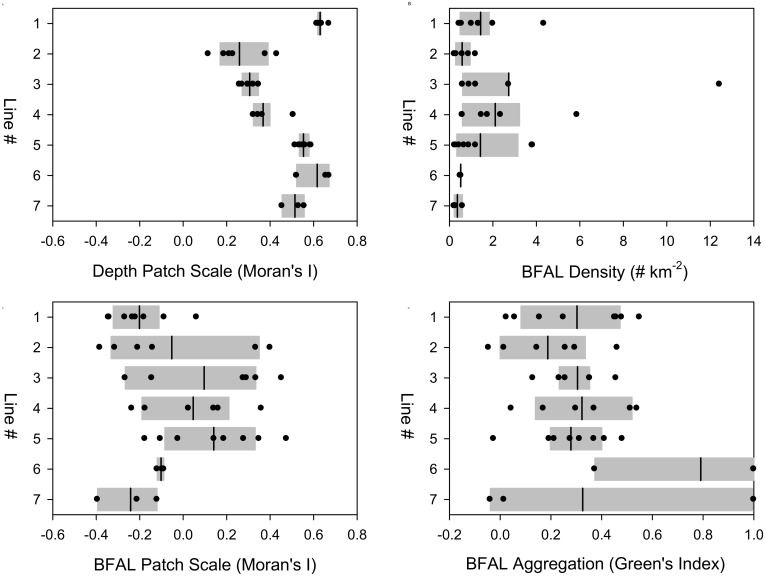
Boxplots of (a) Depth Moran’s I, (b) BFAL density, (c) BFAL Moran’s I, and (d) BFAL Green’s index by survey line, numbered from north (1) to south (7) (Fig 1).The vertical black lines denote the mean, the grey shading indicate the 25% and 75% of the distributions, and the circles show the individual observations.